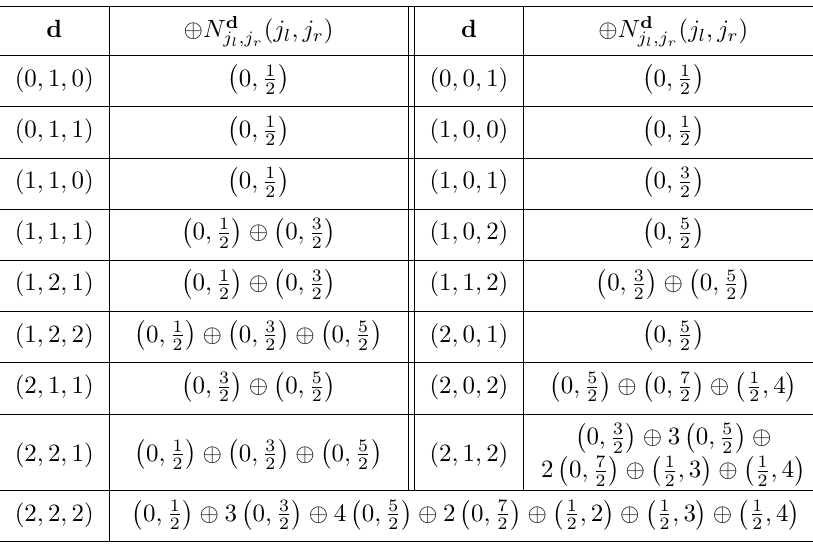
Table 9. BPS spectrum of SU(3) 9 theory for d i ≤ 2 . Here, d = ( d 1 , d 2 , d 3 ) labels BPS states with charge d 1 e 2 + d 2 f 1 + d 3 f 2